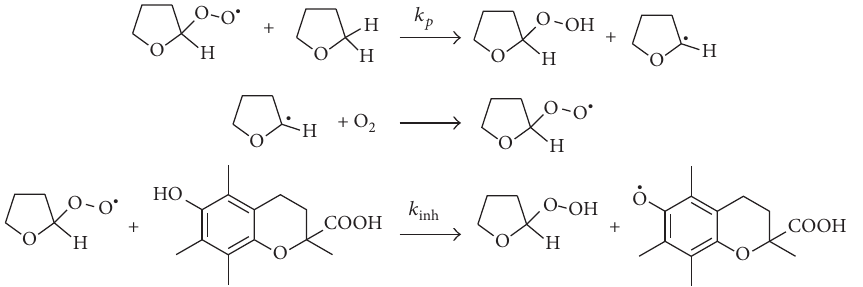
Table 2: Values of 𝑘 (M −1 s −1 ) in buffered water and in organic solvents of different polarity. inh Antioxidant Water, pH 2.1